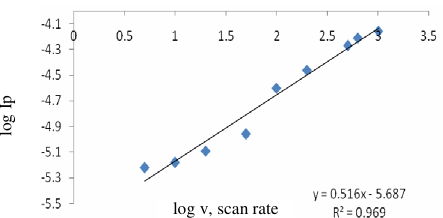
Figure 4 . Plot of log Ip versus log v . Effect of varying scan rates of 0.1 mM paracetamol a using MgB /GC electrode in 0.1 M KH PO (pH 6.0) at a scan rate rang from 5-1000 mV/s 2 2 4